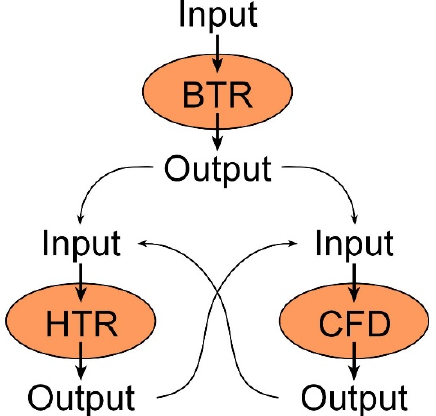
Figure 1. Flowchart of the coupling between the different numerical models.